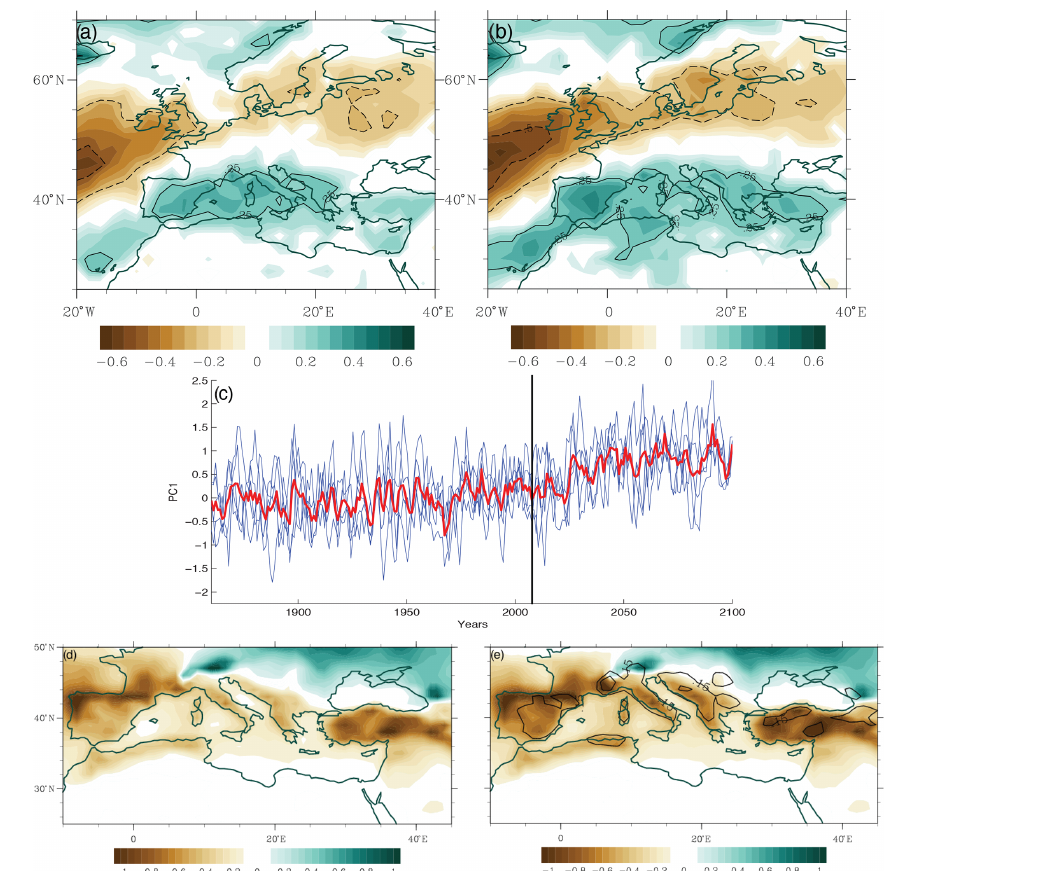
Figure 8. (a, b) Correlations (shaded) between the SNAO time series and precipitation in the 1900–1950 (a) HIST runs and 2050–2100 (b) PROJ runs. Contours denote 0.25 and 0.5. (c) Evolution of SNAO SLP time series in the 1850–2100 period for each run (blue) and the ensemble mean (red). The vertical line divides the HIST and PROJ time series. (d, e) Projected future changes in the summer precipitation (mmd − 1 ) (as in Fig. 7c, except estimated at 1 ◦ horizontal resolution), (d) including SNAO impact and (e) with the impact of the future SNAO removed (shaded). Contours in (e) denote regions where the drying is stronger by 0.15mmd − 1 compared to (d) . The impact of SNAO is estimated based on the linear regression between the detrended time series of SNAO and